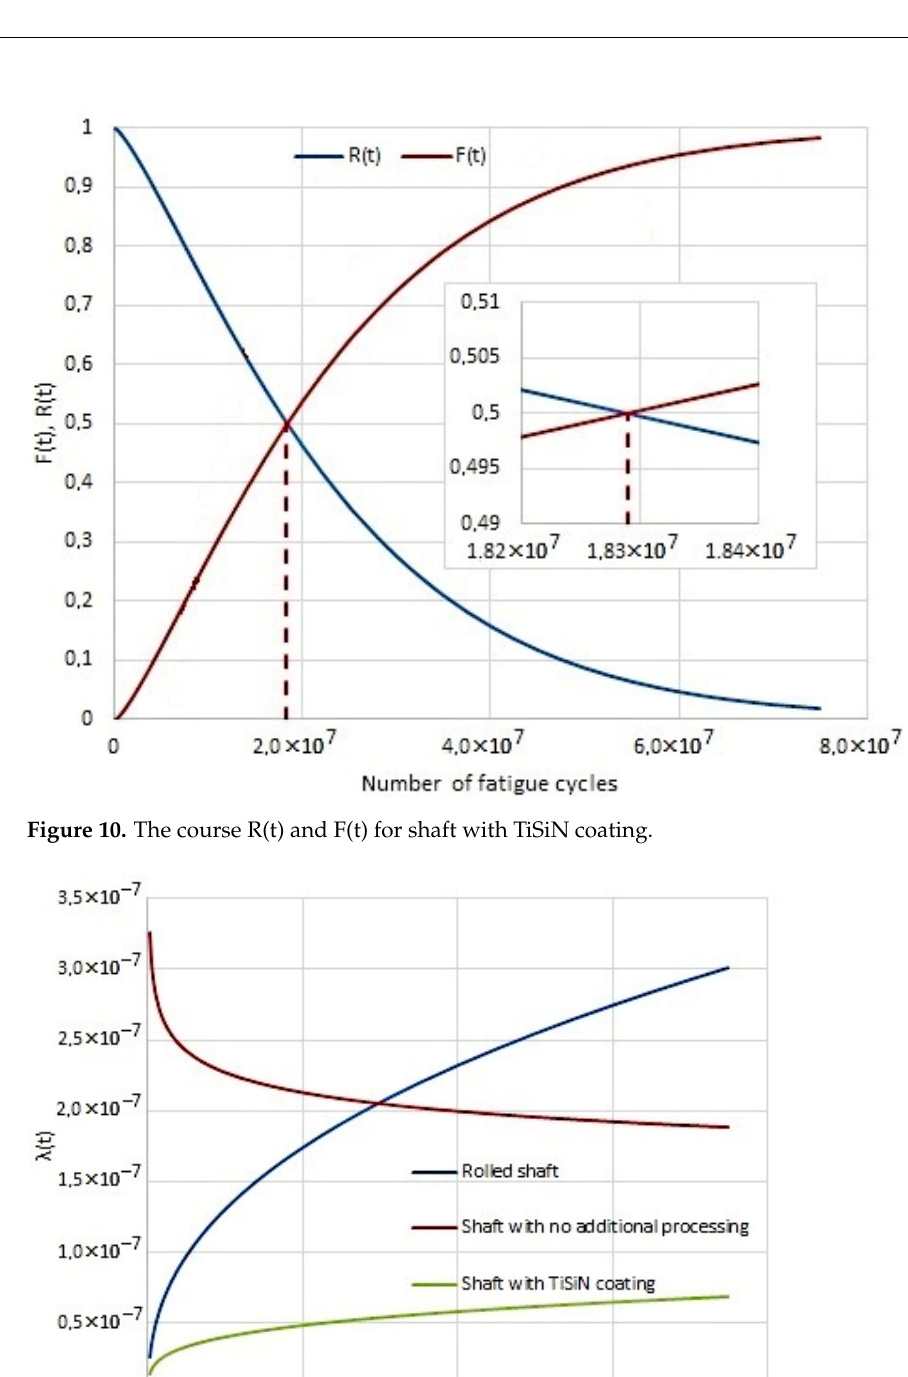
Figure 11. Failure rate.